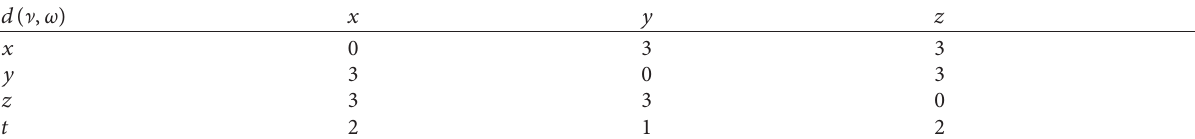
Table 1: Definition of metric